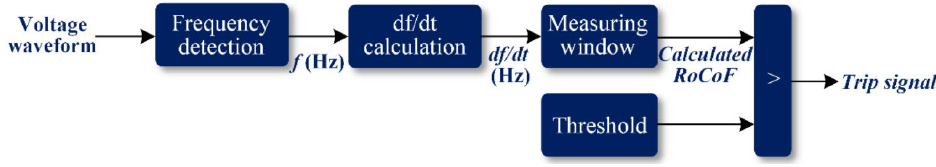
Figure 6. Conventional method for acquiring the grid RoCoF value.